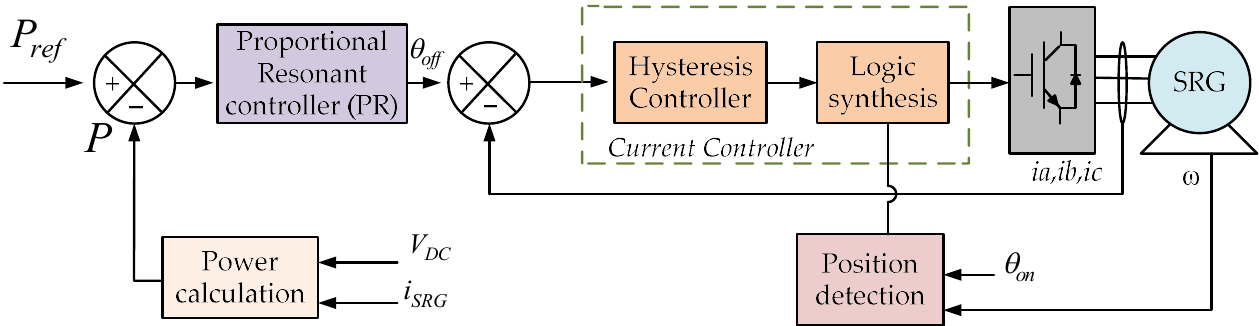
Figure 16. Block diagram of direct power control based on PR controller.